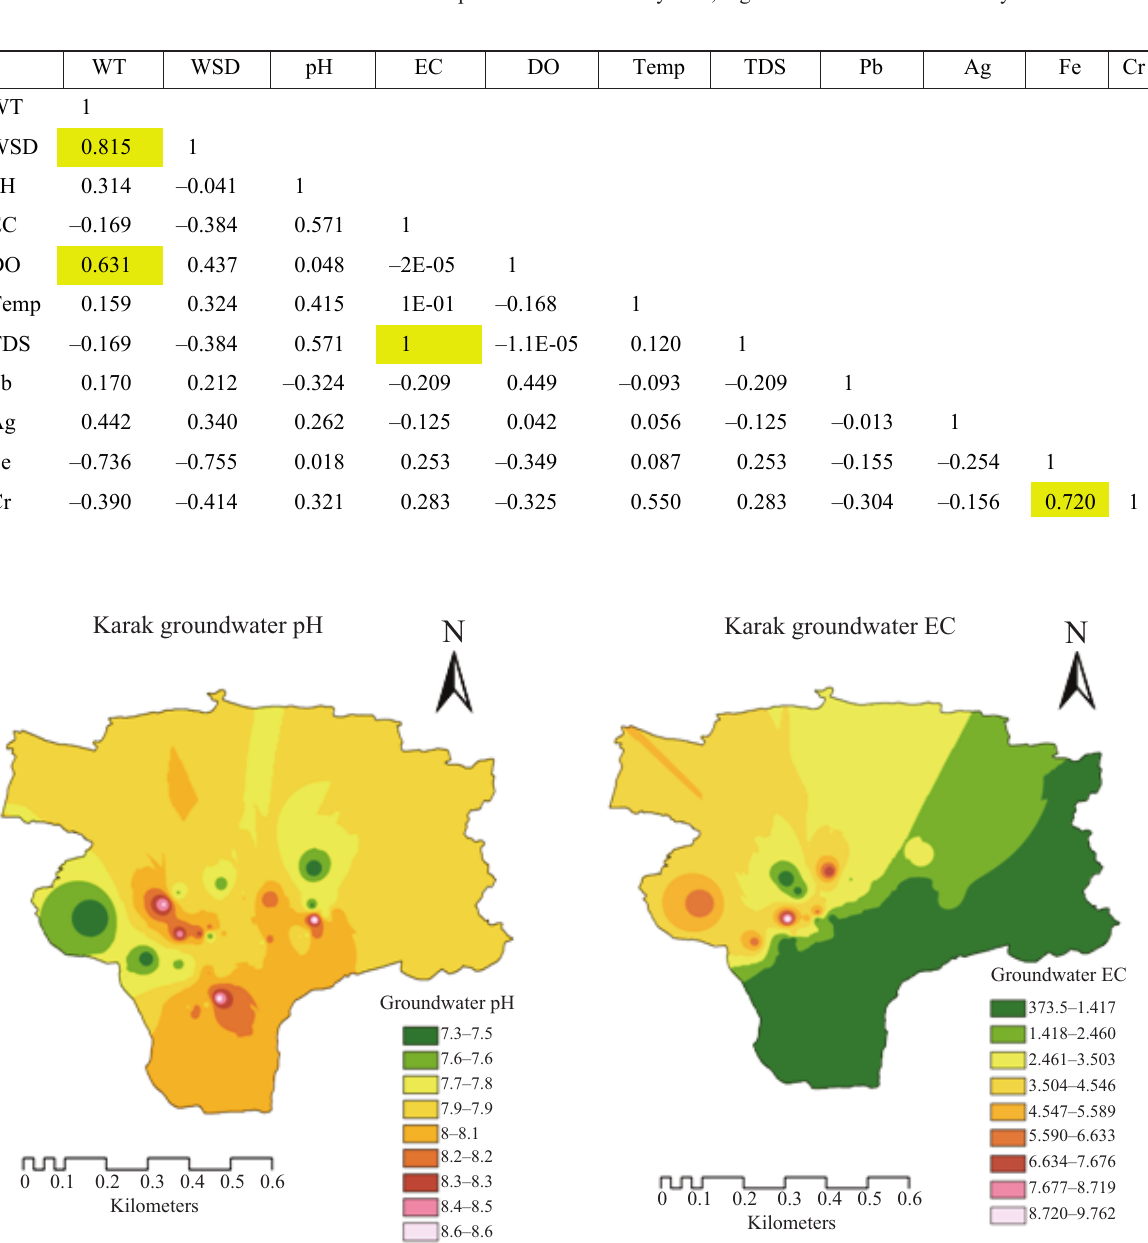
Table 4. Correlation matrix of TW water parameters in the study area, high correlations are shown in yellow